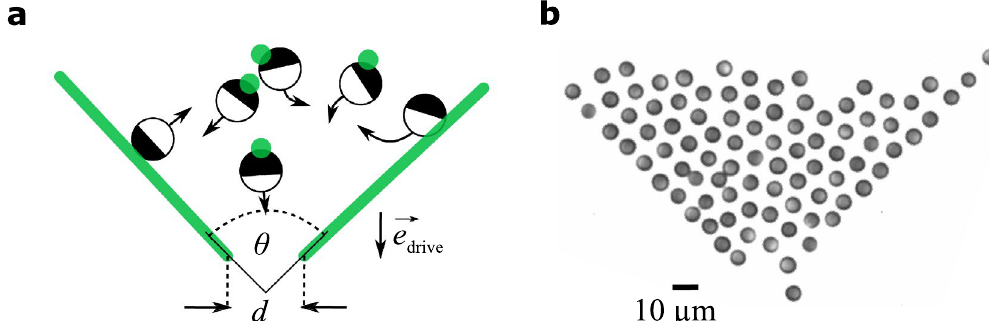
Figure 1. Experimental realisation. ( a ) Sketch of the experimental setup: Janus particles are located inside a bottleneck (width d and opening angle θ ) set by a constant applied light gradient. The active motion is induced by targeting the APs with single laser spots (sketched as green circles). ( b ) Microscope image of the experimental implementation of a bottleneck with θ = 90 ◦ , d = 2.3 σ and β = 0